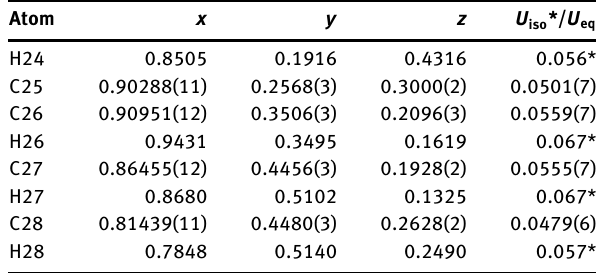
Table 2: Fractional atomic coordinates and isotropic or equivalent isotropic displacement parameters (Å 2